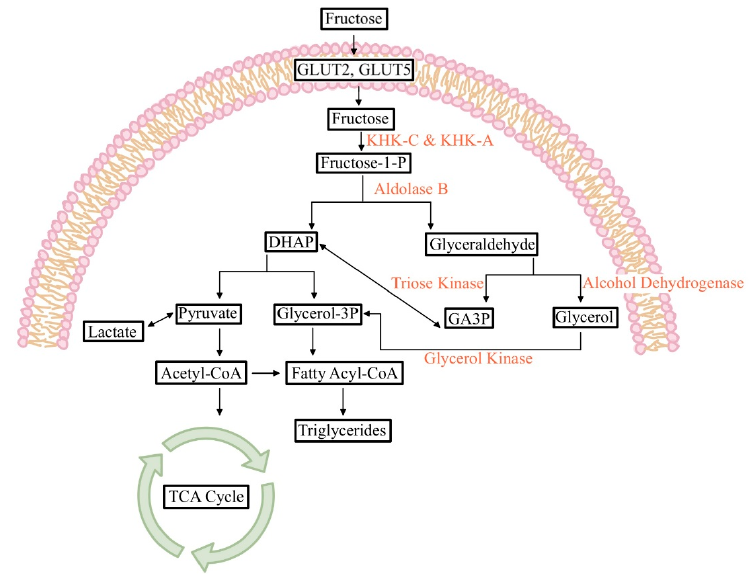
Figure 1. Fructose metabolism pathway. Fructose taken up by Glut2 or Glut5 is subsequently phosphorylated by ketohexokinase (KHK) into fructose-1-phosphate. Aldolase B then cleaves it to three carbon units, dihydroxyacetone phosphate (DHAP), and glyceraldehyde. Glyceraldehyde becomes glyceraldehyde-3-phosphate (GA3P) to enter glycolysis or becomes glycerol-3-phosphate to provide the glycerol backbone of newly synthesized lipids (e.g.,